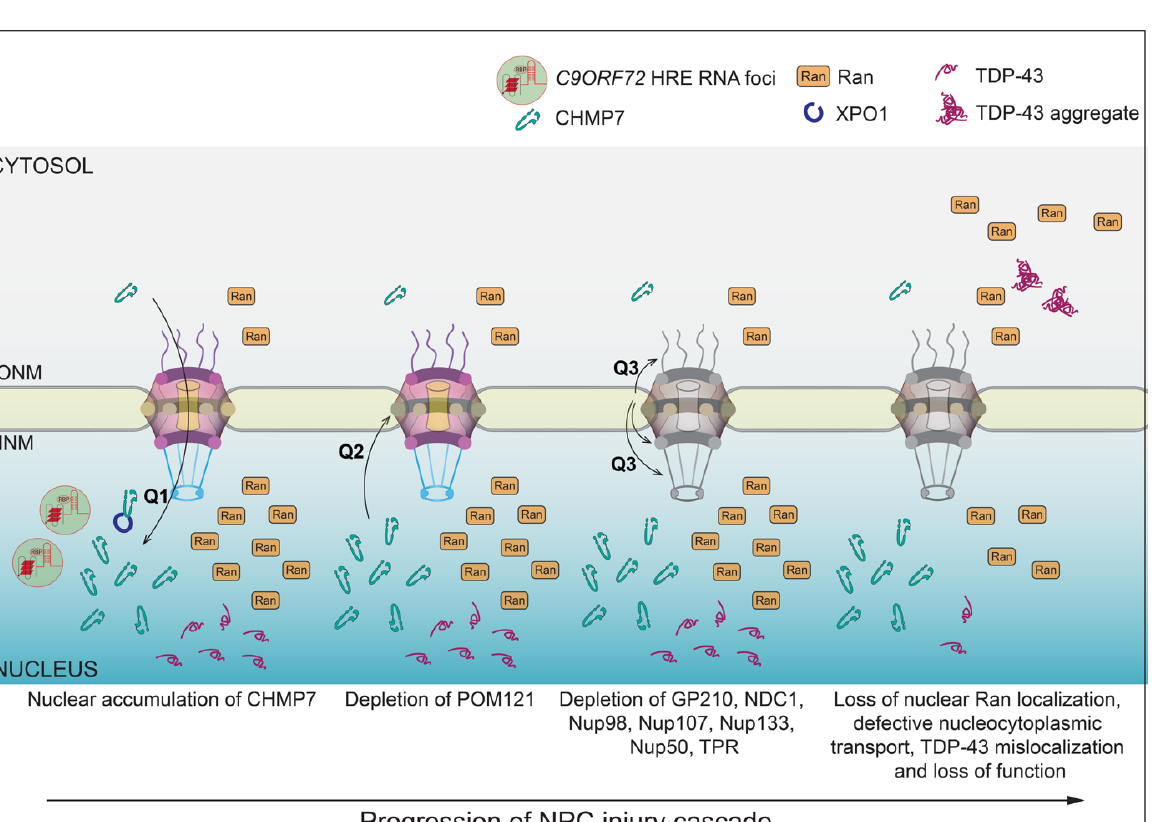
Figure 2. Model of the NPC injury cascade observed in C9-ALS IPSNs with key unknown questions (Q). NPC injury is thought to proceed in a stepwise process (left to right) beginning with an insult that leads to CHMP7 nuclear import or inhibition of its nuclear export by XPO1 (Q1). This aberrant accumulation of CHMP7 leads to the loss of the linchpin POM121 through a mechanism that remains ill defined (Q2), which in turn results in the loss of additional nups (Q3). The overall nup loss burden (depicted as graying of the NPC) is suggested to impact nuclear transport and disrupt Ran and TDP-43 localization.